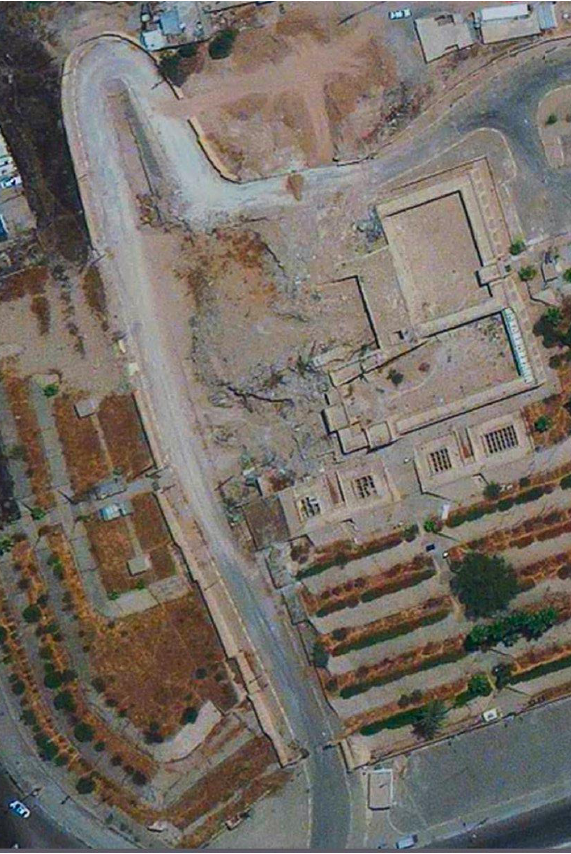
Figure 3. Mosque of Profet Nebi Yunus before the events them, some of the most used are: Correlation Coefficient, Erreur Relative Globale Adimensionalle de Synthese (ERGAS) and Universal Image Quality Index (UIQI), (Maglione, 2016), but for this study the most important parameter was the correct photointerpretation by the final users so, the results of the different procedure were compared mainly in terms of operative possibility to distinguish the changes between the “before” and “after” imagery.